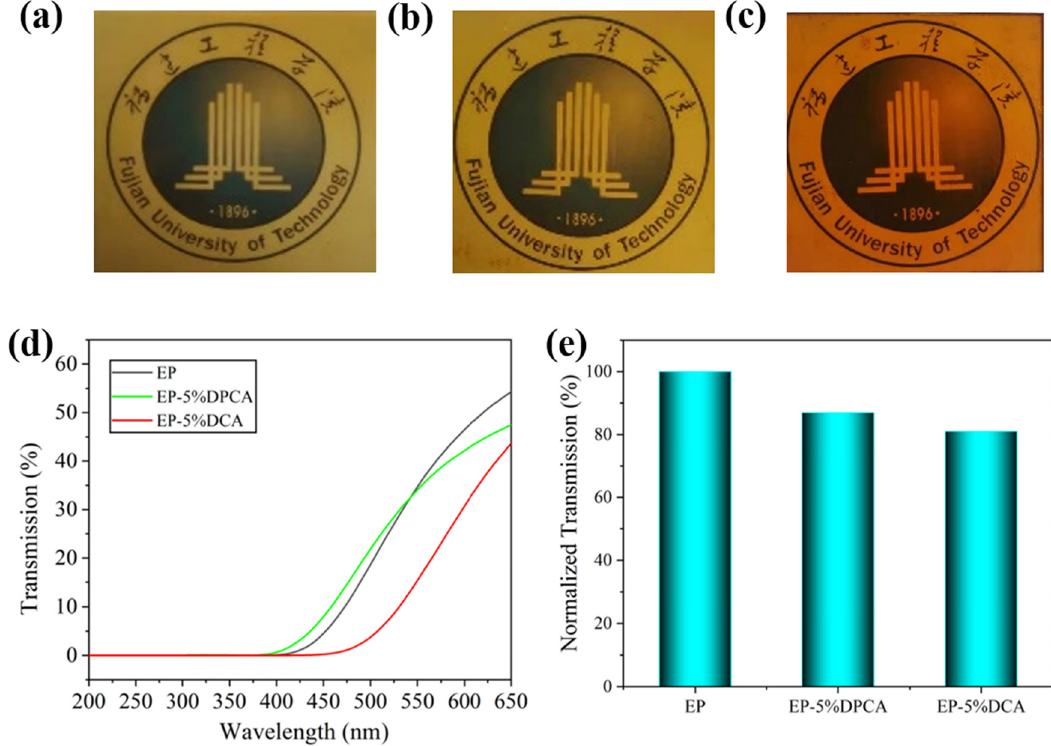
Figure 11: Digital photos of ( a ) EP, ( b ) EP - 5 wt% DPCA, and ( c ) EP - 5 wt% DCA samples. ( d ) UV - Vis spectra curves of EP samples in visible region. ( e ) Normalized transmittance of EP and its